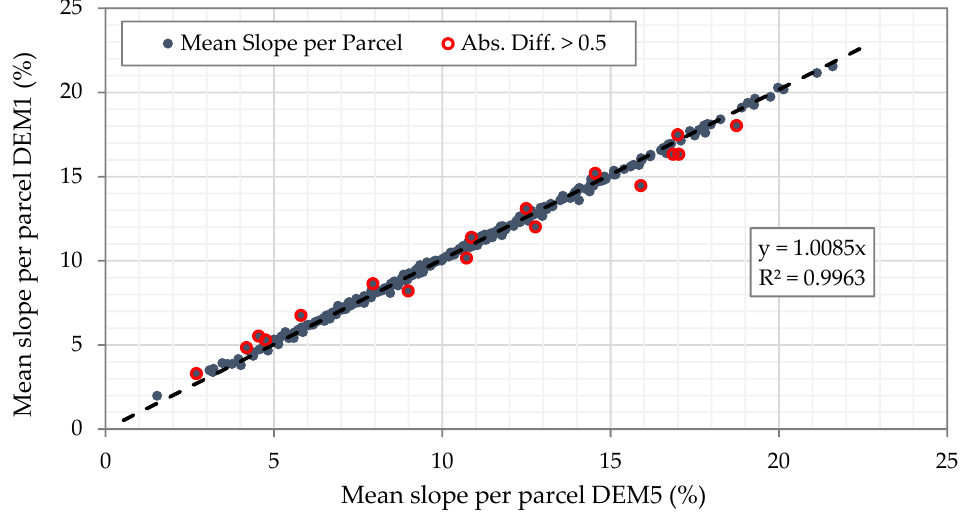
Figure 10. Comparison of mean slope per arable parcel for DEM1 and DEM5. Red points indicate an absolute difference greater than 0.5%; data source: [30,40].